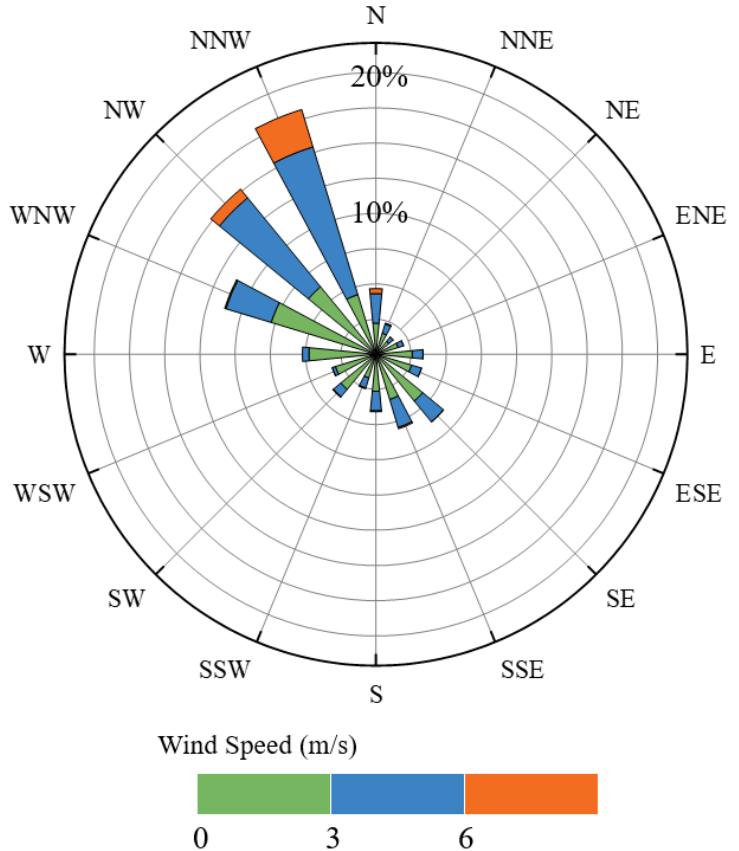
Figure 7. Wind rose chart at Changsha meteorological station.